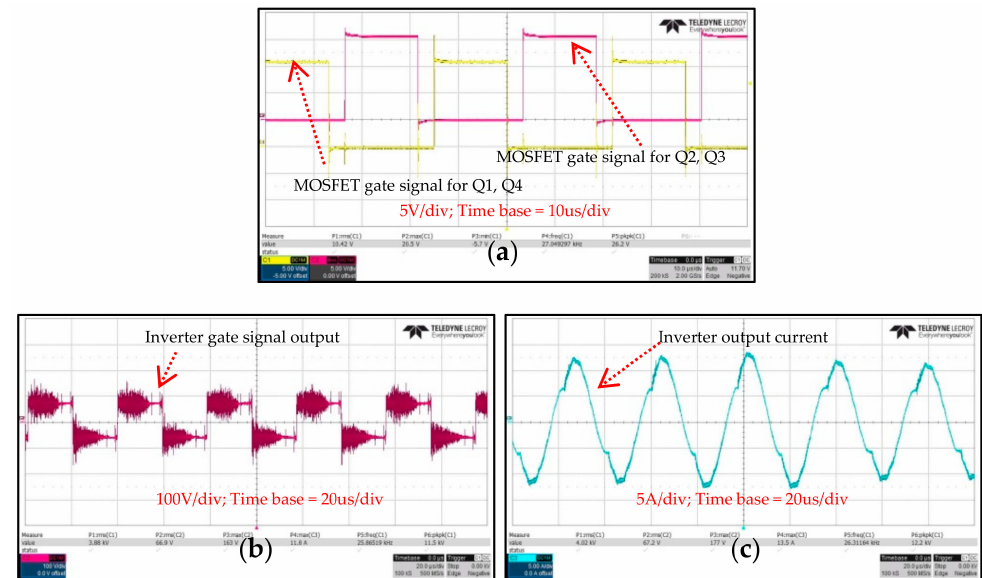
Figure 8. High frequency PWM inverter control and output waveforms. ( a ) MOSFET gate signals; ( b ) inverter gate signal output; ( c ) inverter output current.